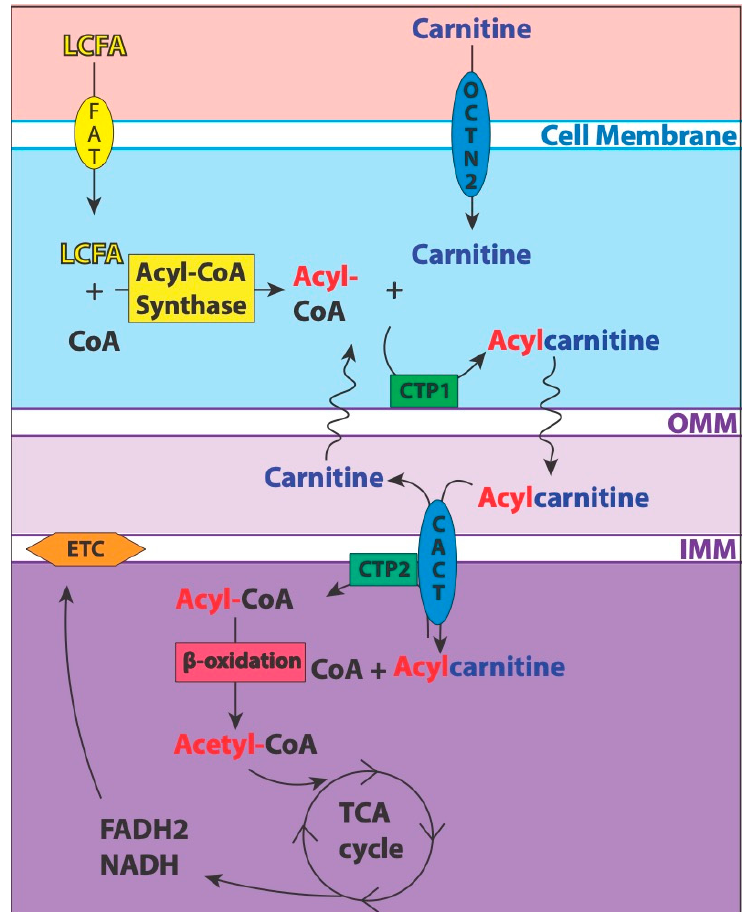
Figure 1. The Carnitine Shuttle. The figure highlights the major components of the carnitine shuttle system used to import long-chain fatty acids (LCFA) into the mitochondria for oxidation. LCFA are converted to acyl-CoA via acyl-CoA synthase. Then, the enzyme, carnitine palmitoyltransferase (CPT) 1, produces acylcarnitines from acyl-CoA and free carnitine. Carnitine-acylcarnitine translocase (CACT) moves acylcarnitine across the inner mitochondrial membrane (IMM) as carnitine is exported out. CPT2 converts the acylcarnitine back into acyl-CoA and free carnitine. Acyl-CoA is then available for β -oxidation that produces 1 molecule of acetyl-CoA per cycle of oxidation, which enters the TCA cycle. The cycle provides the necessary electron donors to feed into the electron transport chain (ETC), thus powering oxidative phosphorylation.FAT = fatty acid transferase, CoA = coenzyme A, OCTN2 = organic cation/carnitine transporter 2, TCA cycle = tricarboxylic acid cycle, FADH2 and NADH = electron donors, OMM/IMM = outer/inner mitochondrial membrane.